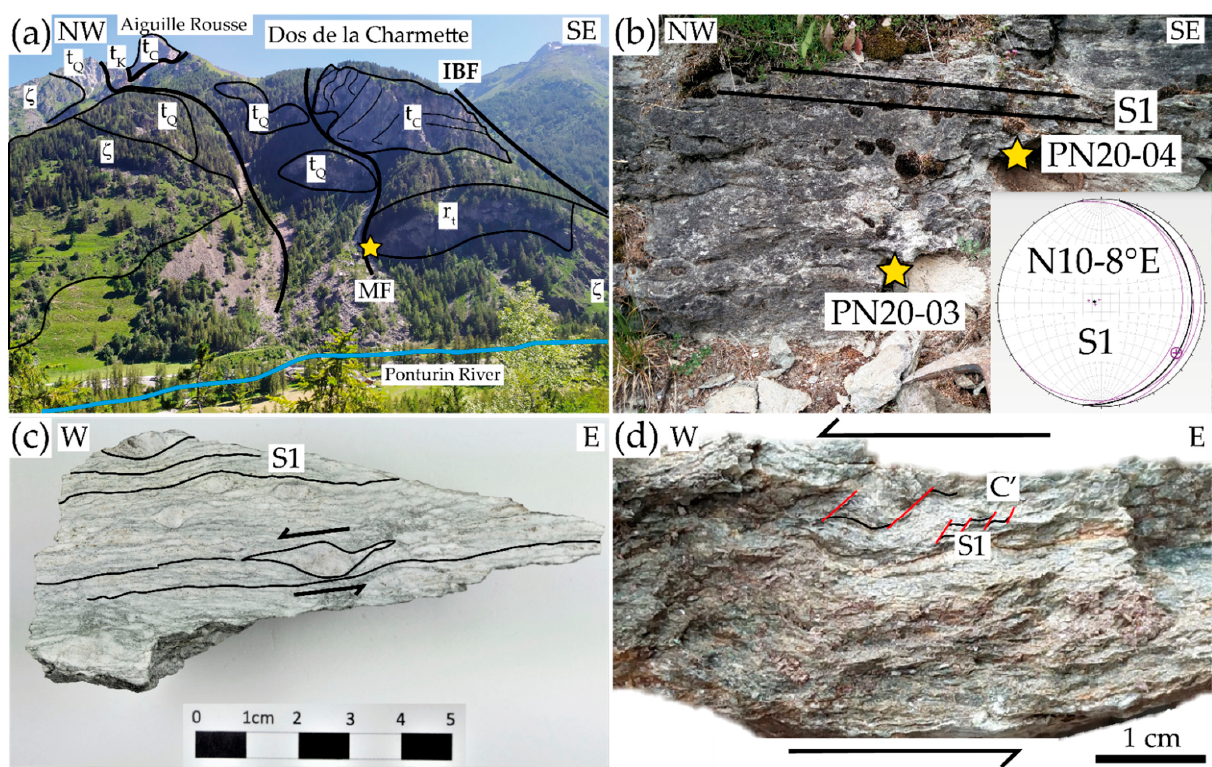
Figure 2. ( a ) Photo of the Peisey-Nancroix valley (PN on the Figure 1b), Ponturin River right bank with outcrop location b (yellow star), and ( b ) outcrop of Permian schist and quartzite (rt) with the stereonet of the S1 schistosity and samples location (yellow stars). ( c , d ) Photo of the two samples from the PN outcrop showing a top-to-the-west kinematic of deformation: ( c ) Mylonitic quartzite with the schistosity highlighted by phyllite and the direction given by deformed porphyroclast of quartz (PN20-03); ( d ) Schist with shear planes (red line; C’) transecting the main schistosity (S1) at an angle of about 30–60 ◦ (PN20-04). ζ : Sapey gneiss; rt: Permian schist and phyllitic